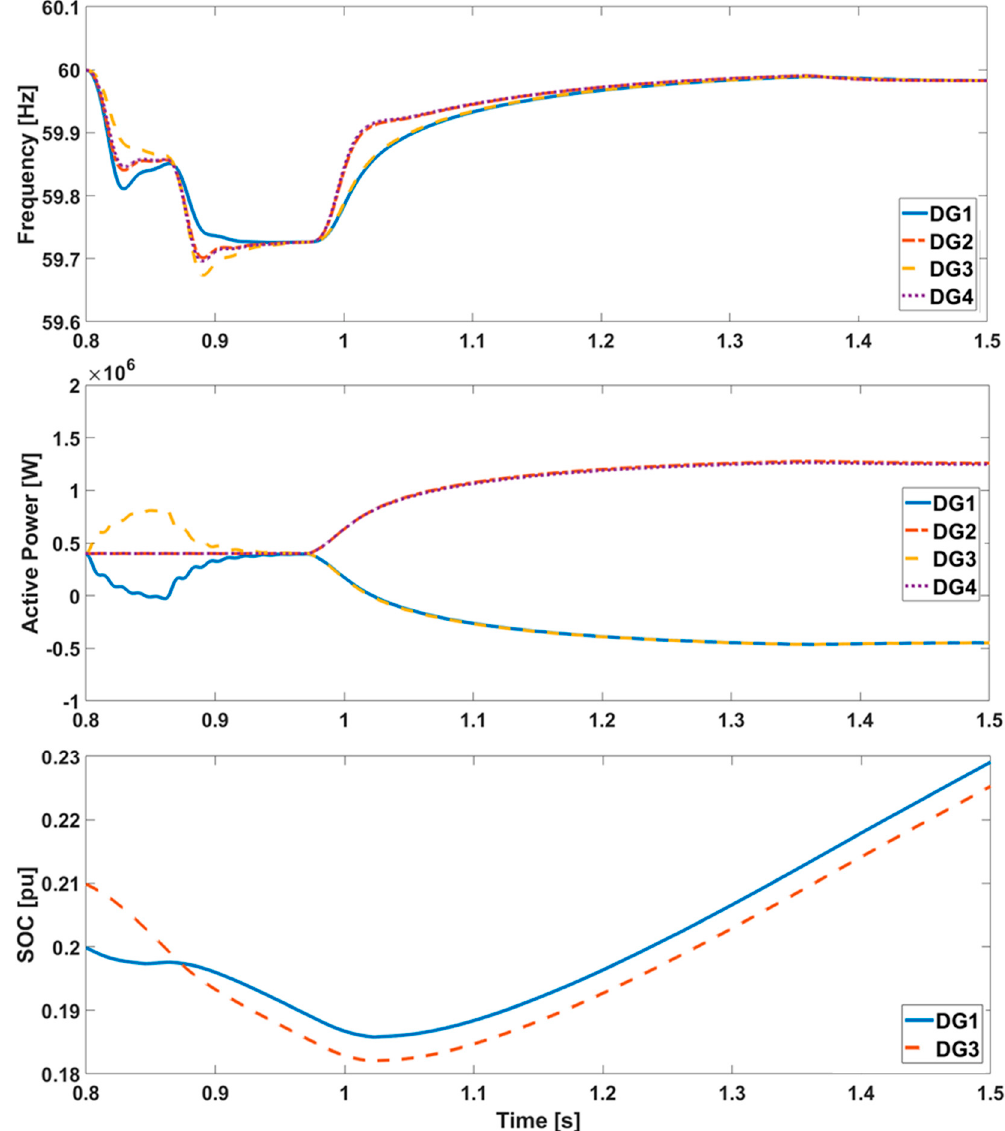
Figure 8. SOC restoration results for SOC difference of 1% between DG1 and DG3.